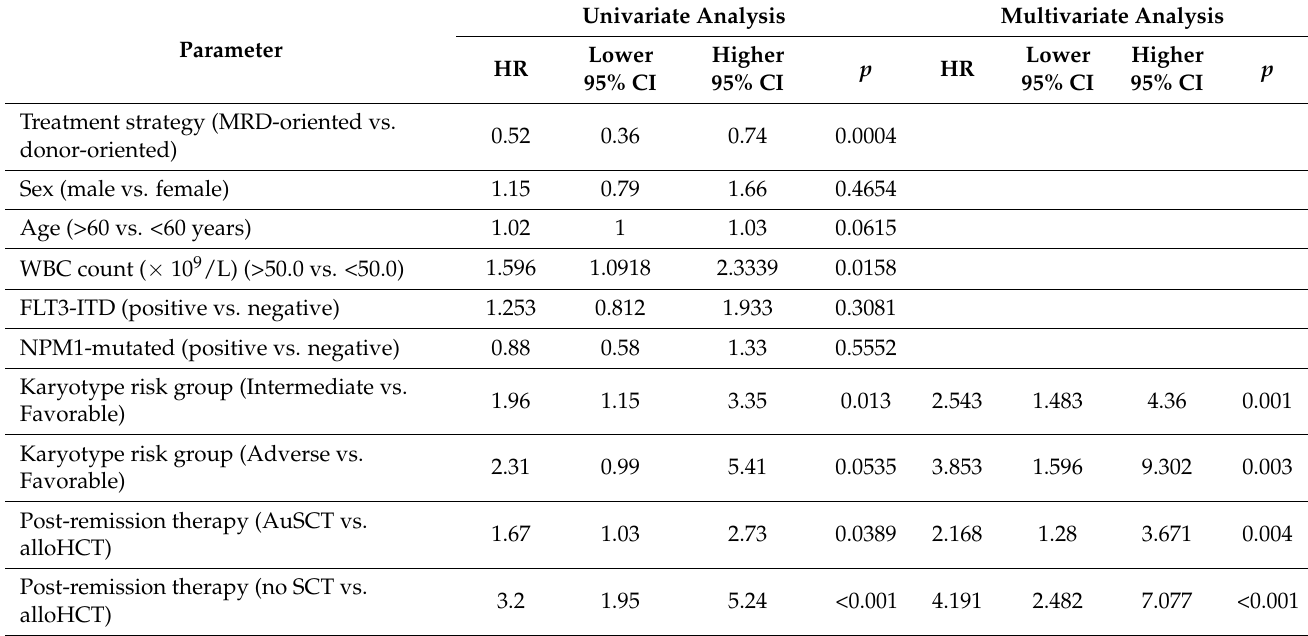
Table 3. Univariate and multivariate analysis for Disease Free